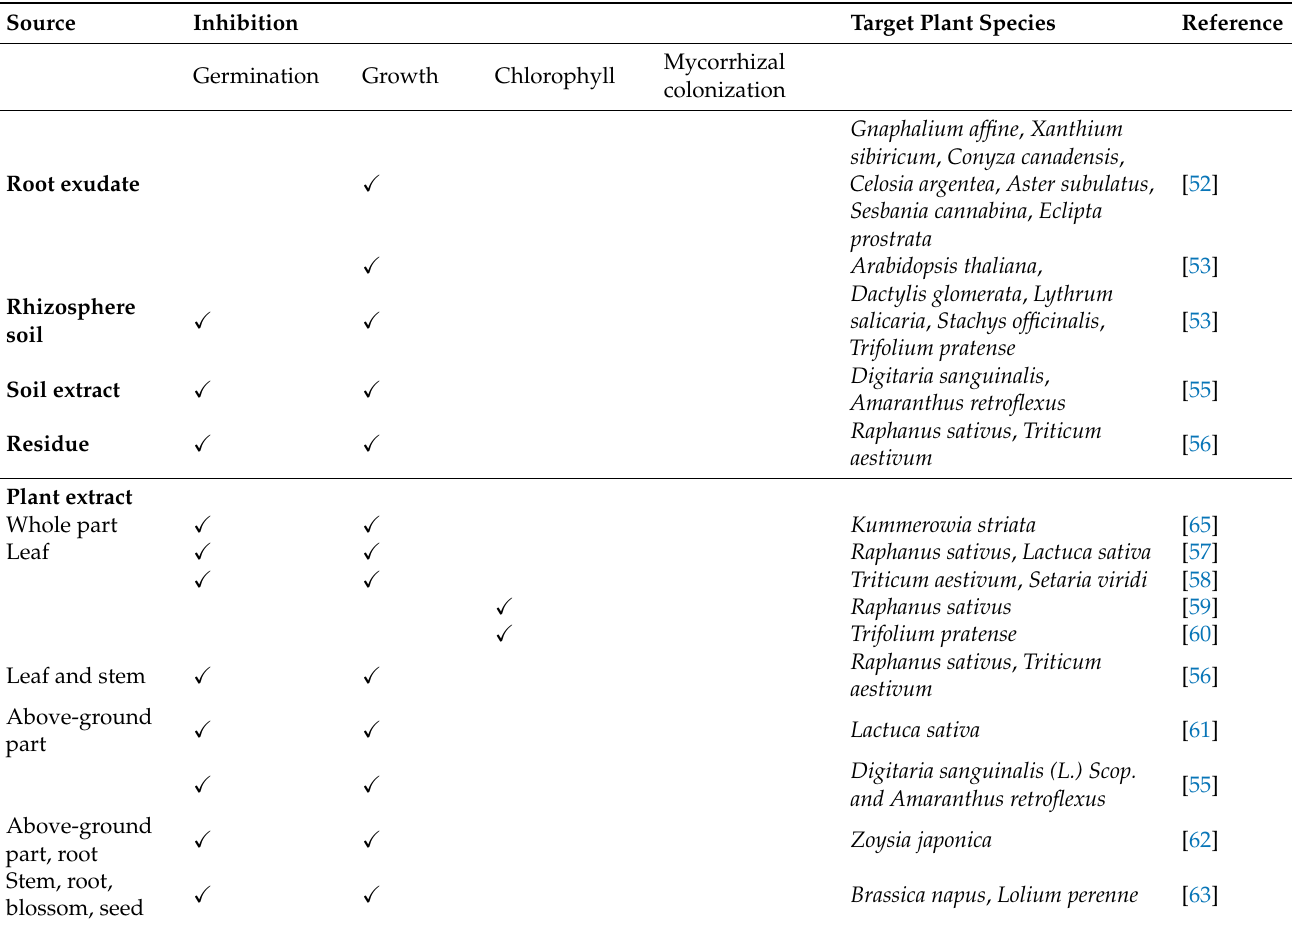
Table 1. Allelopathic activities of exudates, rhizosphere soil, residues and plant extracts of S. canadensis